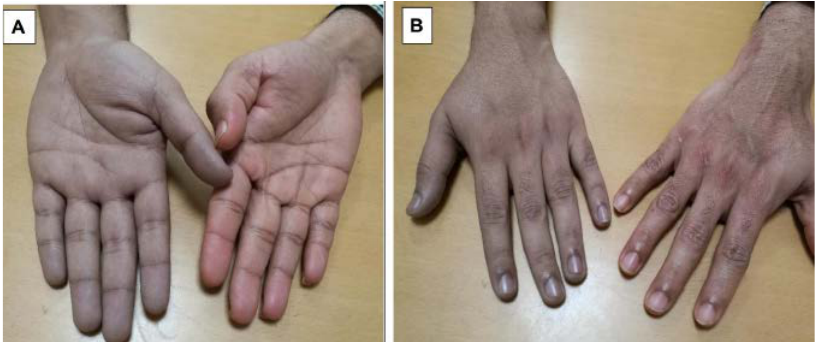
Figure 1. Peripheral cyanosis of patient’s hand at diagnosis compared to his brothers’ palm: anterior (A) and posterior view